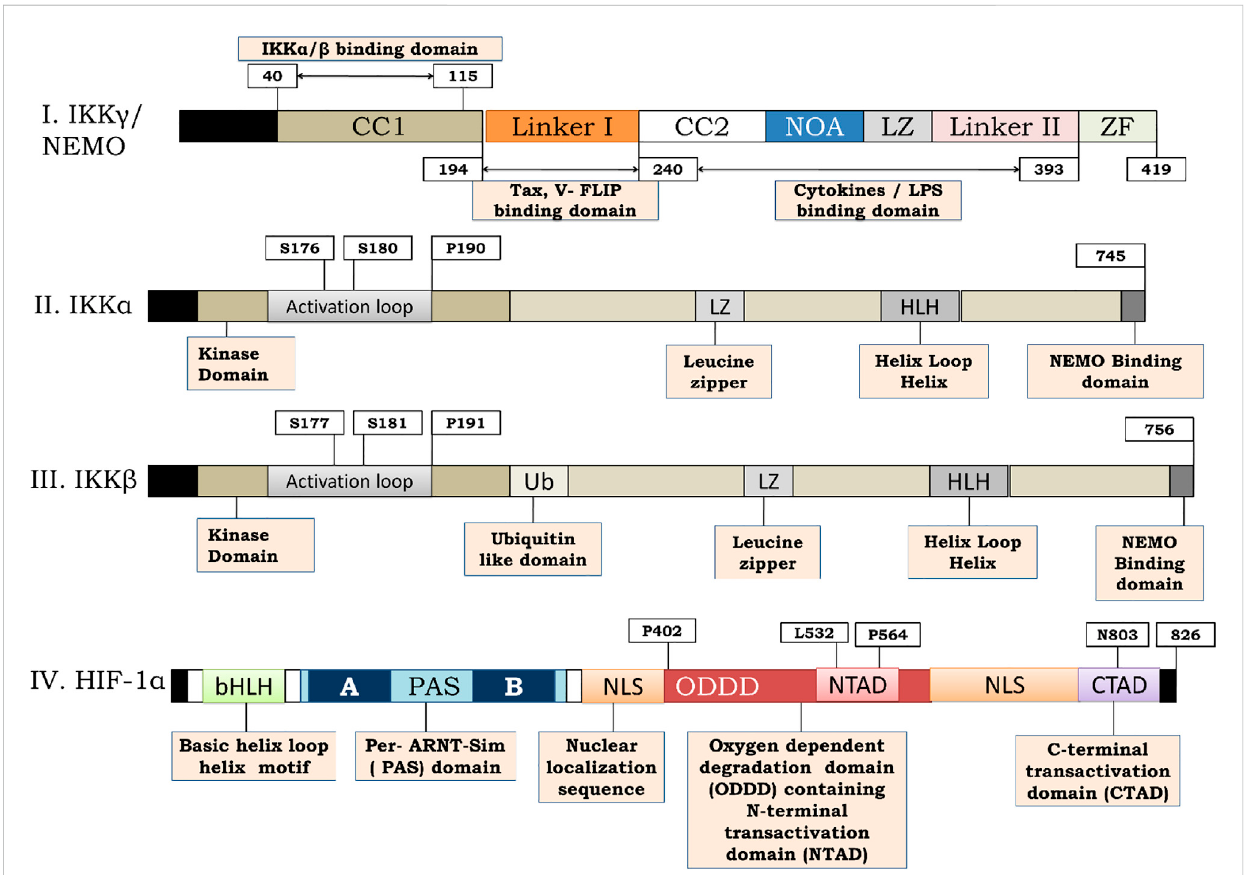
FIGURE 4 StructureofIKK γ ,IKK α ,IKK β andHIF-1 α . (I) RepresentsthestructureofIKK γ orNEMO.IKK γ isa419aminoaciddimericfragmentconsistingofaseries of parallel intermolecular coiled coil domains (represented as CC1 and CC2). The amino acid terminus (N-terminus) is vital for interaction with IKK α and IKK β . Linker 1 serves for interaction with viral trans activators like HTLV-1 and Tax and V-Flip. C-terminus function for signal transmission while NOA and ZincFinger(ZF)domainsbindtopolyubiquitinchains. (II,III) representsthestructureofIKK α andIKK β respectively.IKK α isa745aminoacidfragment consistingofanactivationloopfromaminoacid176 – 180whereasIKK β isa756aminoacidfragmentconsistingofactivationloopfrom177 – 181onamino terminous. A ubiquitin like domain is present (from amino acid 307 – 384) on carboxy terminous of IKK β but not on IKK α . The function of leucine zipper domain isto allow homo and heterodimerization of thekinases. The function of helix loop helix is lessclear but it seems to beinvolvedinthe modulation ofkinaseactivity.A 40aminoacid regionattheextremecarboxy terminousofthekinases(AA-705 – 743)isrequired fortheir interaction withNEMO. (IV) - represents the structure of HIF-1 α . HIF-1 α is a 826 amino acid sequence consisting of basic helix loop helix motif and a PAS domain. The sequence possess a N-terminal trans activation domain (N-TAD) on Oxygen dependent degradation domain (ODDD) of HIF-1 α along with C-terminal transactivation. The HIF-1 α consists of prolyl hydroxylation site at Pro402 and P4 as w ro56ell as pVHL binding site at Leu532 respectively on that lie on ODDD. The CTAD of HIF-1 α consists of Asparginyl hydroxylation site at